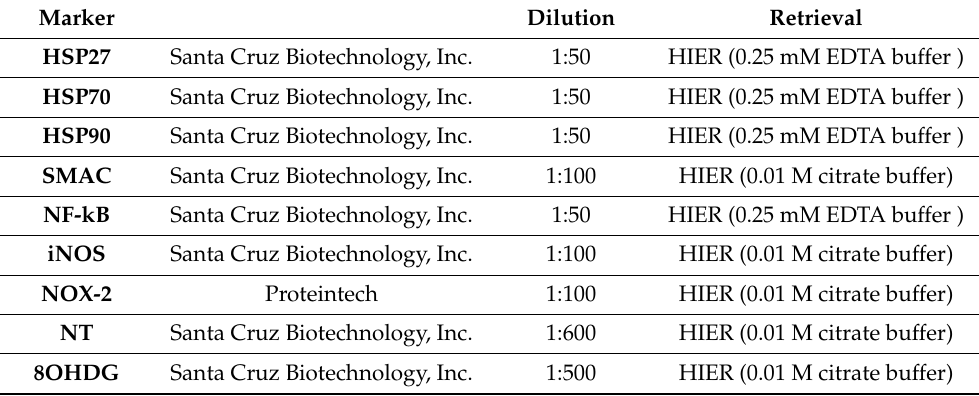
Table 6. Antibodies used for immunohistochemical analyses with the relative dilutions and antigenic retrieval